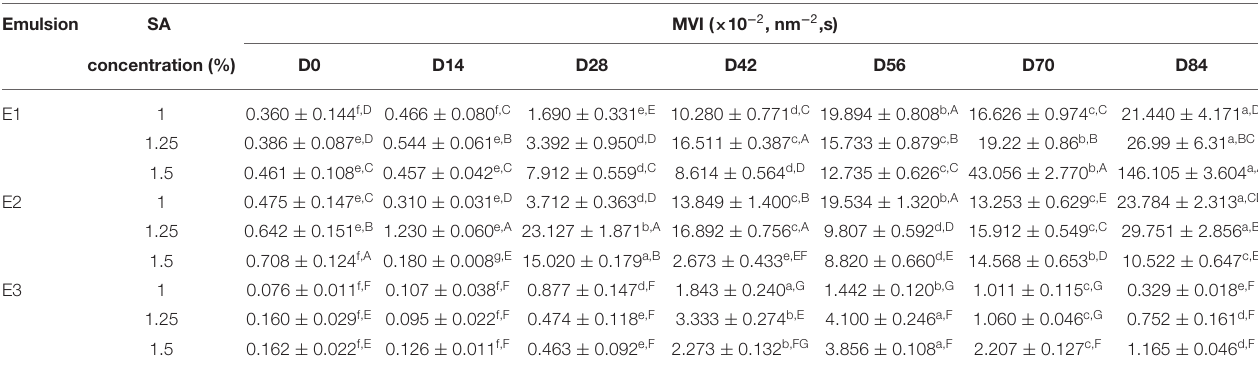
TABLE 4 | Macroscopic viscosity index of E1, E2, and E3 emulsions under different storage times. Emulsion concentration